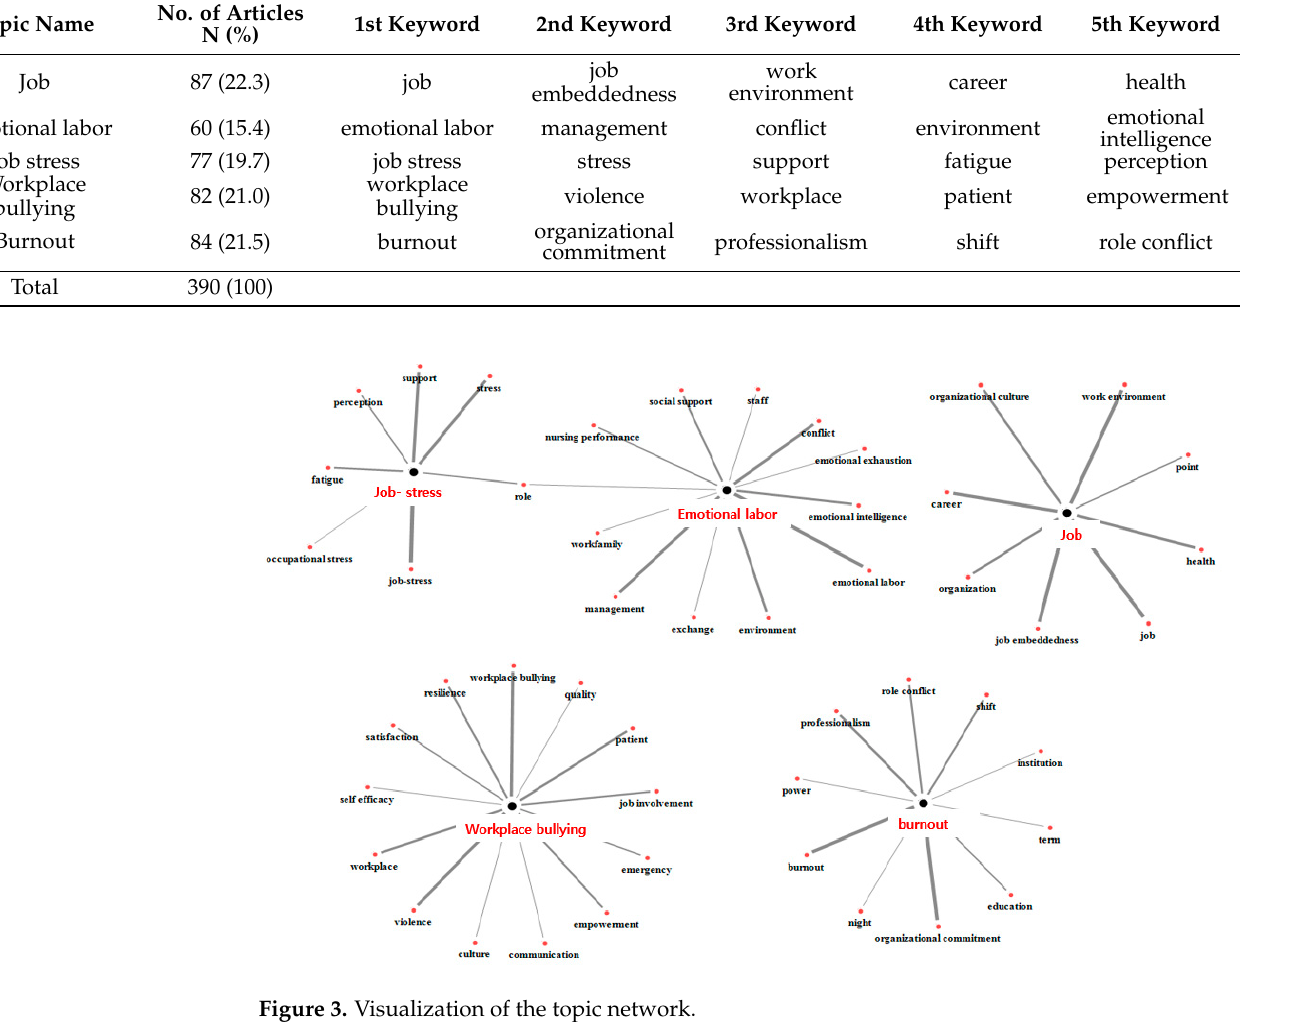
Figure 3. Visualization of the topic network.